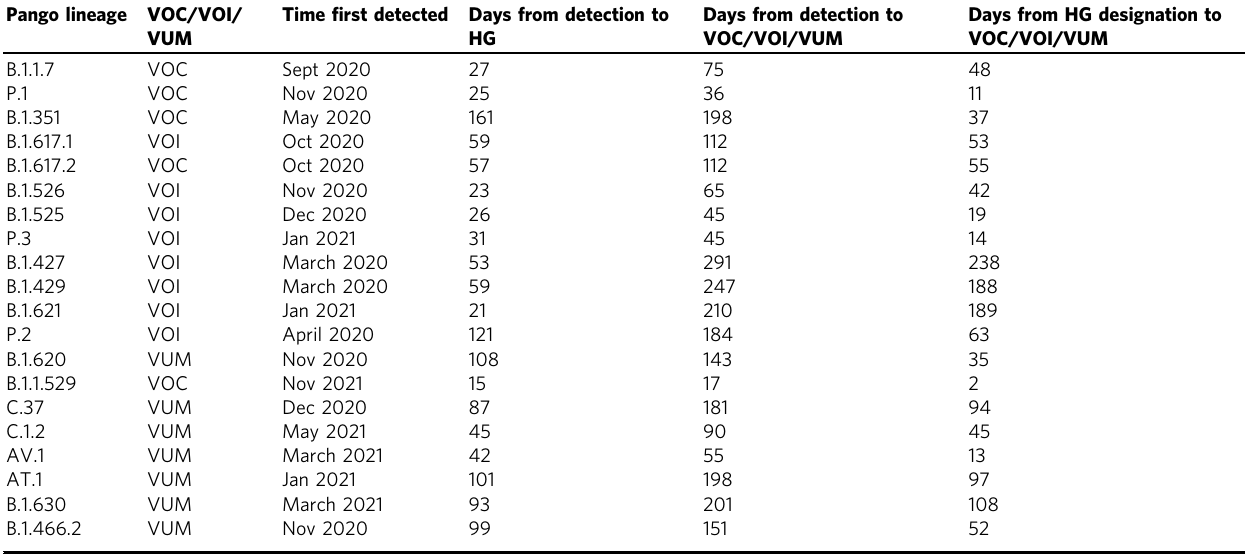
Pango Lineage: lineage according to the Pango nomenclature. VOC/VOI/VUM: status as VOC, VOI or VUM. Time fi rst detected: time of isolation of the fi rst genome associated with the variant. Days from fi rst detection to HG: days intercurring from the isolation of the fi rst genome to the appearance of a corresponding HG. Daysfrom detection to VOC-VOI-VUM: daysintercurring from the isolation of the fi rst genome associated with a variant to the acknowledgment of that variant as VOC/VOI/VUM by WHO. Days from HG designation to VOC/VOI/VUM: days intercurring from the designation of an HG by HaploCoV to the acknowledgment of the status of a VOC/VOI/VUM according to WHO.